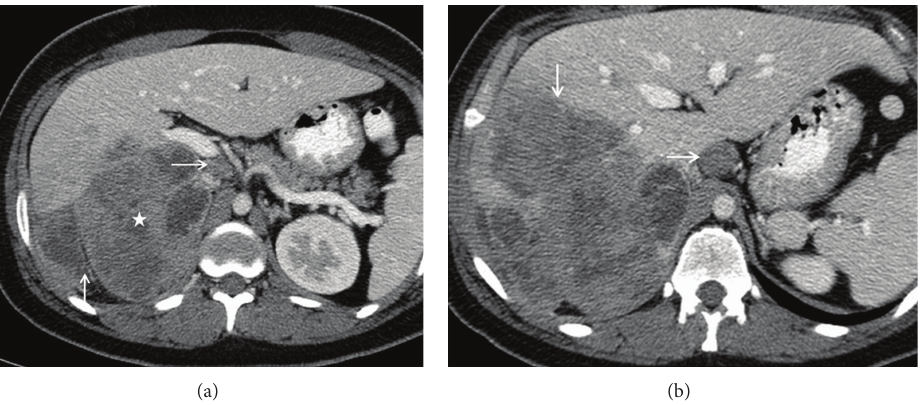
Figure 2: (a) Axial contrast-enhanced multidetector computed tomography (MDCT) image of the upper abdomen reveals a large mass of heterogeneous attenuation replacing the midportion and superior pole of the right kidney (star). Mass has broken into the hepatorenal space (vertical arrow) and invaded the right liver. A metastatic pericaval lymph node is seen (horizontal arrow). (b) Axial contrast-enhanced MDCT image shows a large lobulated component of the renal mass invading the right liver (horizontal arrow). An enlarged metastatic left gastric lymph node is also noted (vertical arrow).